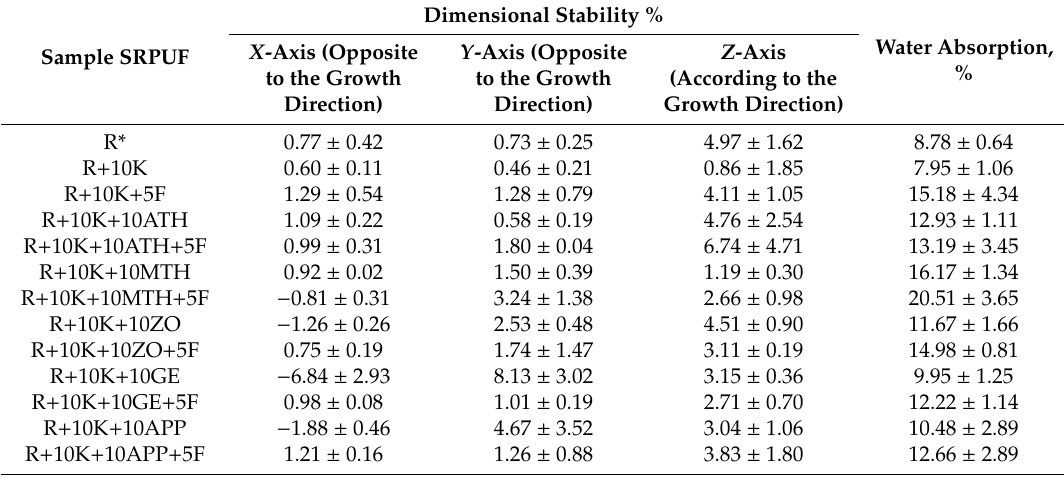
Table 8. Summary of the results of determining the dimensional stability of foams and water absorption. Dimensional Stability % Sample SRPUF